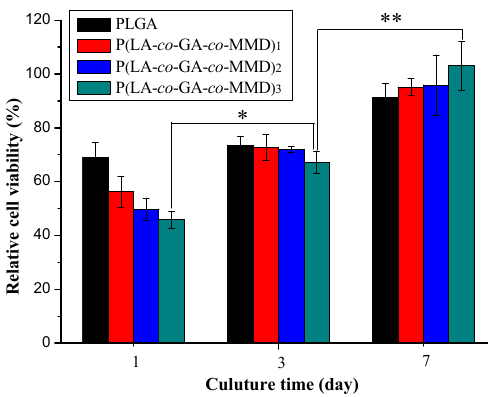
Figure 5. The relative cell viability of HUVECs cultured on PLGA and P(LA- co -GA- co -MMD) nanofibrous scaffolds. (mean ± SD, n = 3, * p ≤ 0.05, ** p ≤ 0.01).